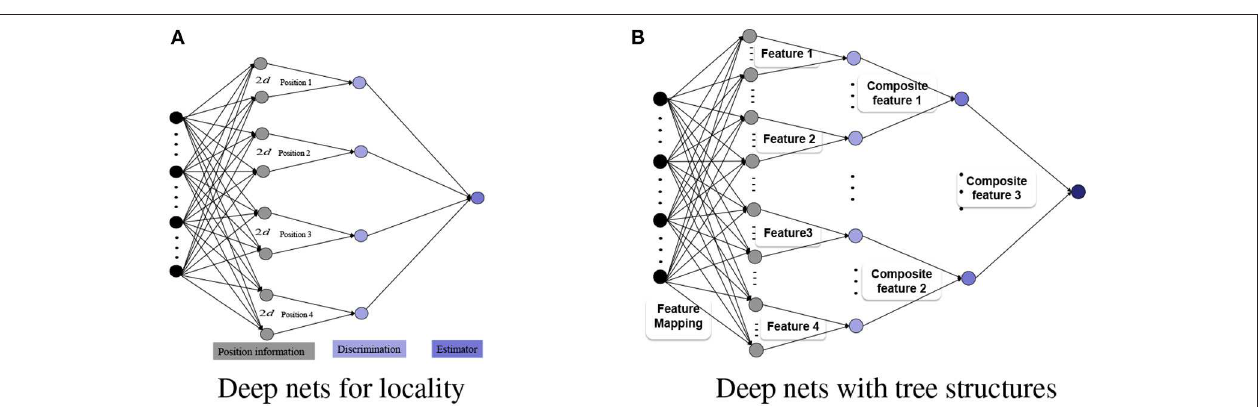
FIGURE 3 | Deep nets with tree structures. (A) Deep nets for locality. (B) Deep nets with tree structures.